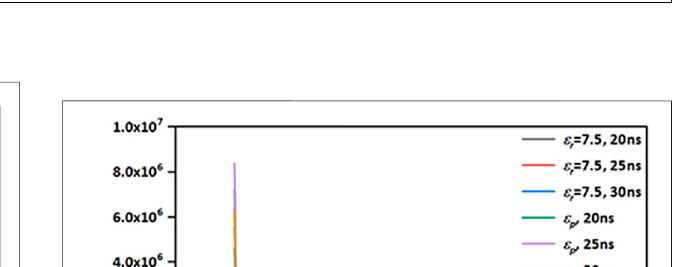
FIGURE 5 | electric fi eld distribution with uniform permittivity (A) and graded permittivity (B) .